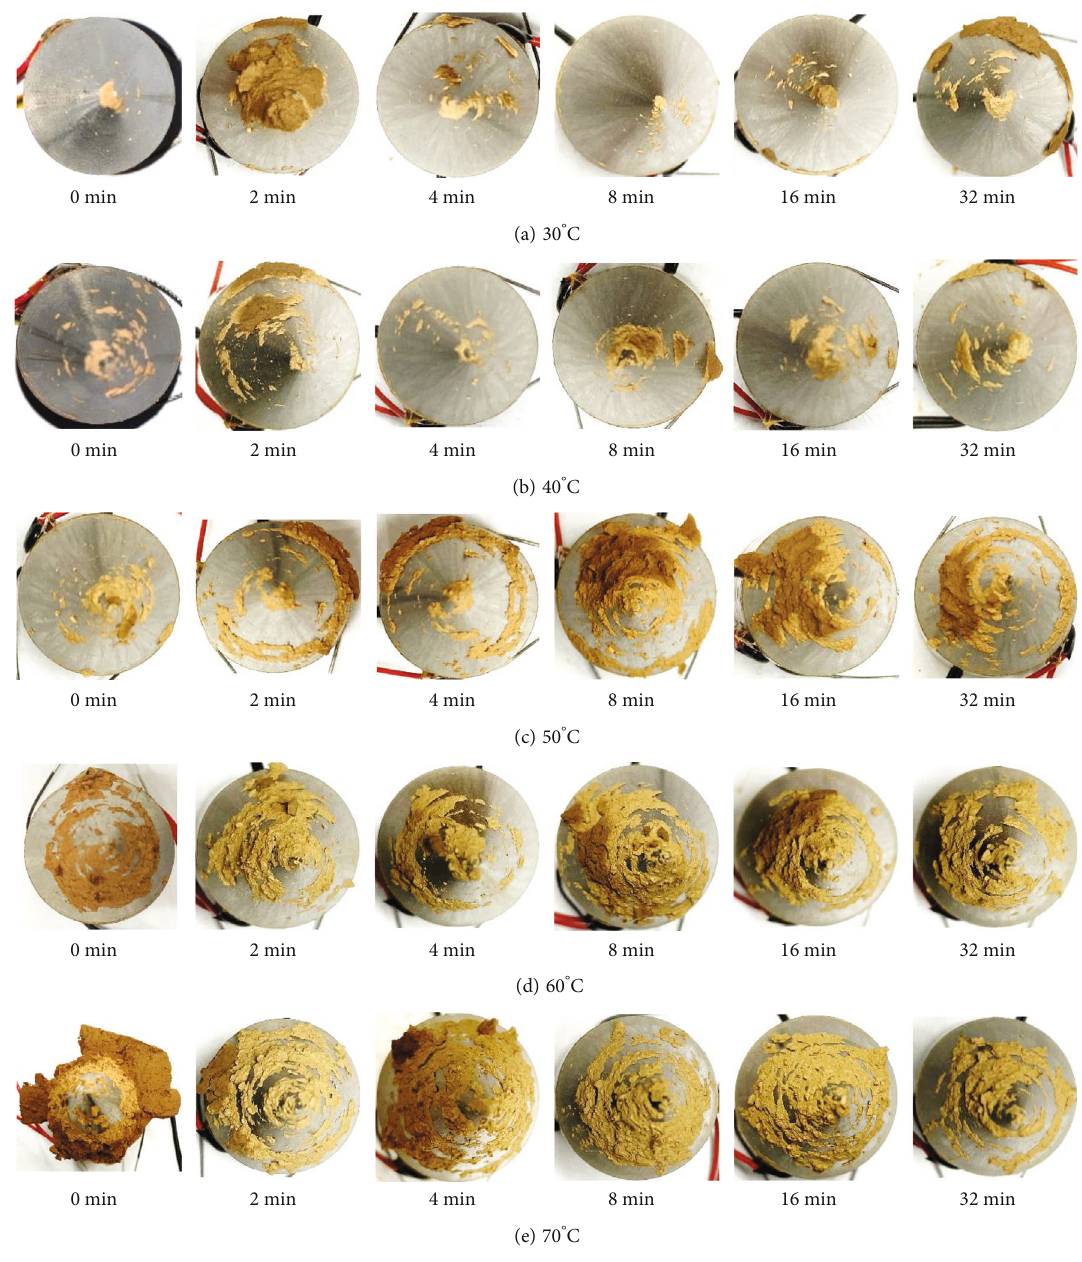
Figure 11: The condition of soil adhering to